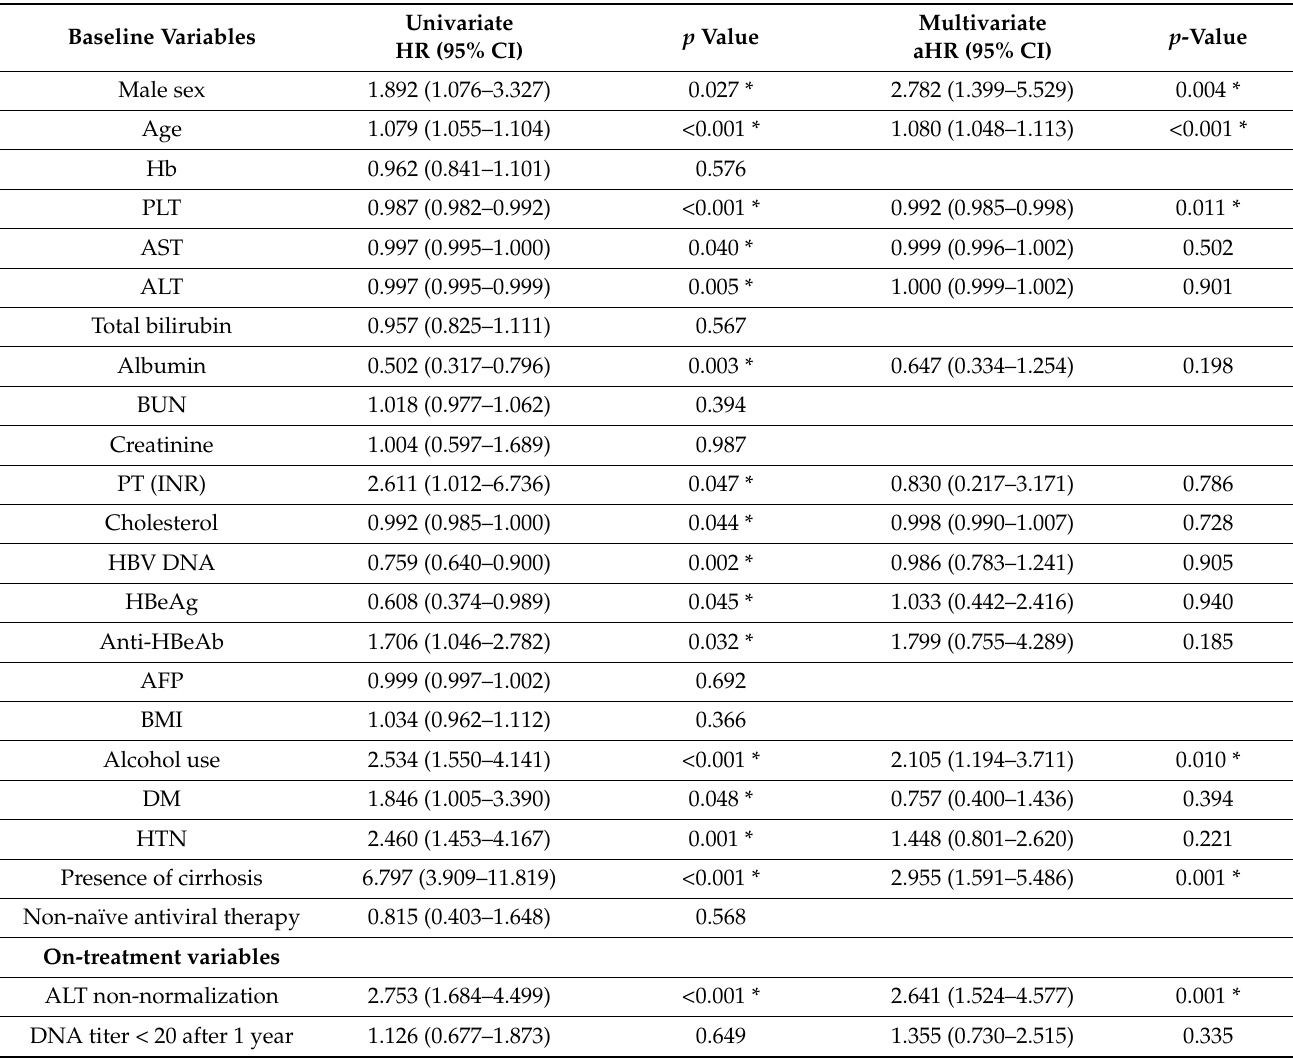
Table 5. Univariate and multivariate analyses for HCC by Cox regression